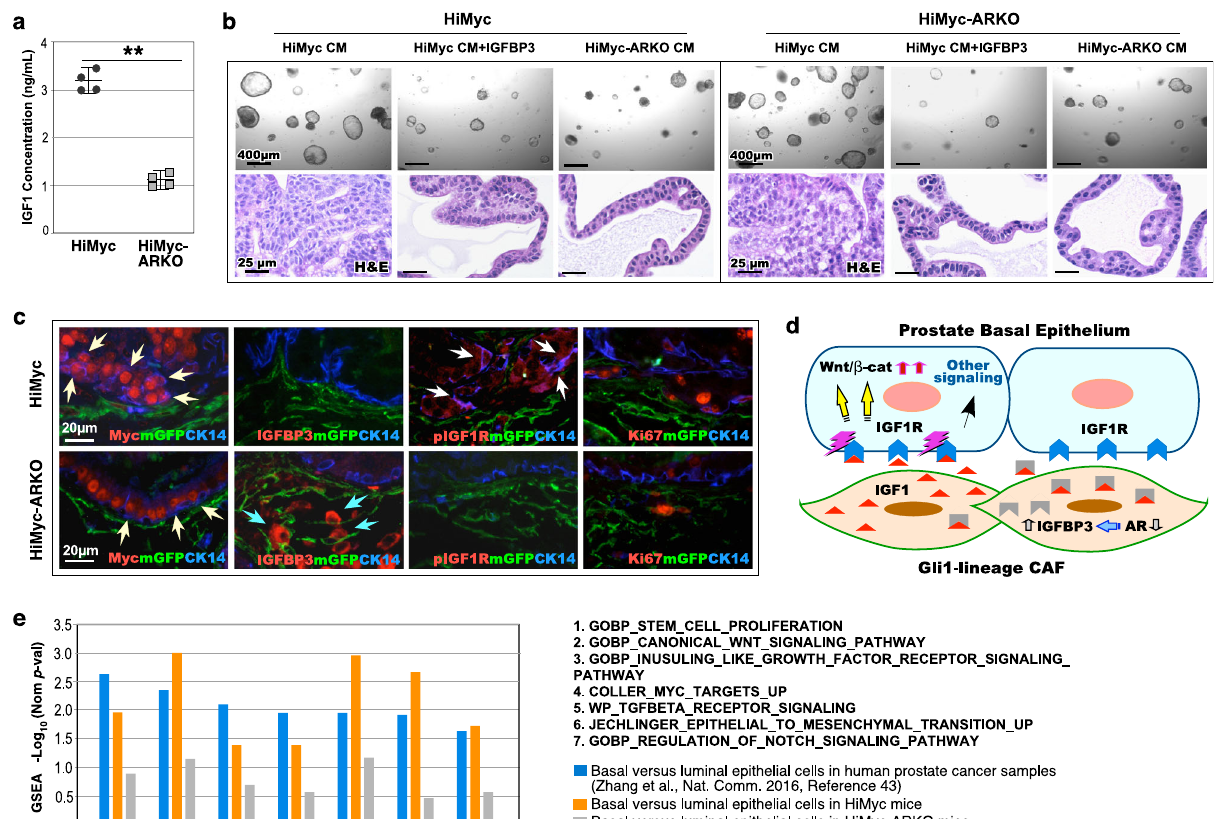
Fig. 7 | Stromal AR in Gli1-lineage cells induces basal epithelial IGF and Wnt pathways to promote oncogenic growth through paracrine action. a IGF1 concentration in conditioned media (CM) from 12-week-old Hi-Myc:R26 mTmG/+ : Gli1 CreER/+ and Hi-Myc:R26 mTmG/+ :Ar L/Y :Gli1 CreER/+ GFP + cells. Data are represented as mean±SDoffourindependentsamplesovertwobiologicalreplicates.Two-sided t test, ** p <0.01.Sourcedataandtheexact p valuesareprovidedasaSourceData fi le. b Organoid culture of prostatic epithelial cells from 12-week-old Hi-Myc:R26 mTmG/+ : Gli1 CreER/+ and Hi-Myc:R26 mTmG/+ :Ar L/Y :Gli1 CreER/+ mice, following treatment with Hi- Myc:R26 mTmG/+ :Gli1 CreER/+ CM, Hi-Myc:R26 mTmG/+ :Gli1 CreER/+ CM+IGFBP3 (1 μ g/ml), or Hi- Myc:R26 mTmG/+ :Ar L/Y :Gli1 CreER/+ CM. Representative bright fi eld images and HE staining showing organoid morphology and structure observed in indicated groups. Scale